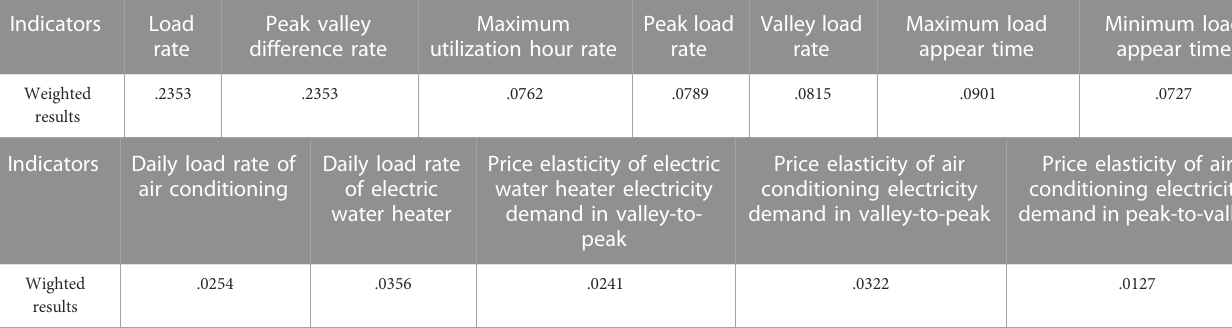
TABLE 4 Indicators weighted results based on CRITIC method.